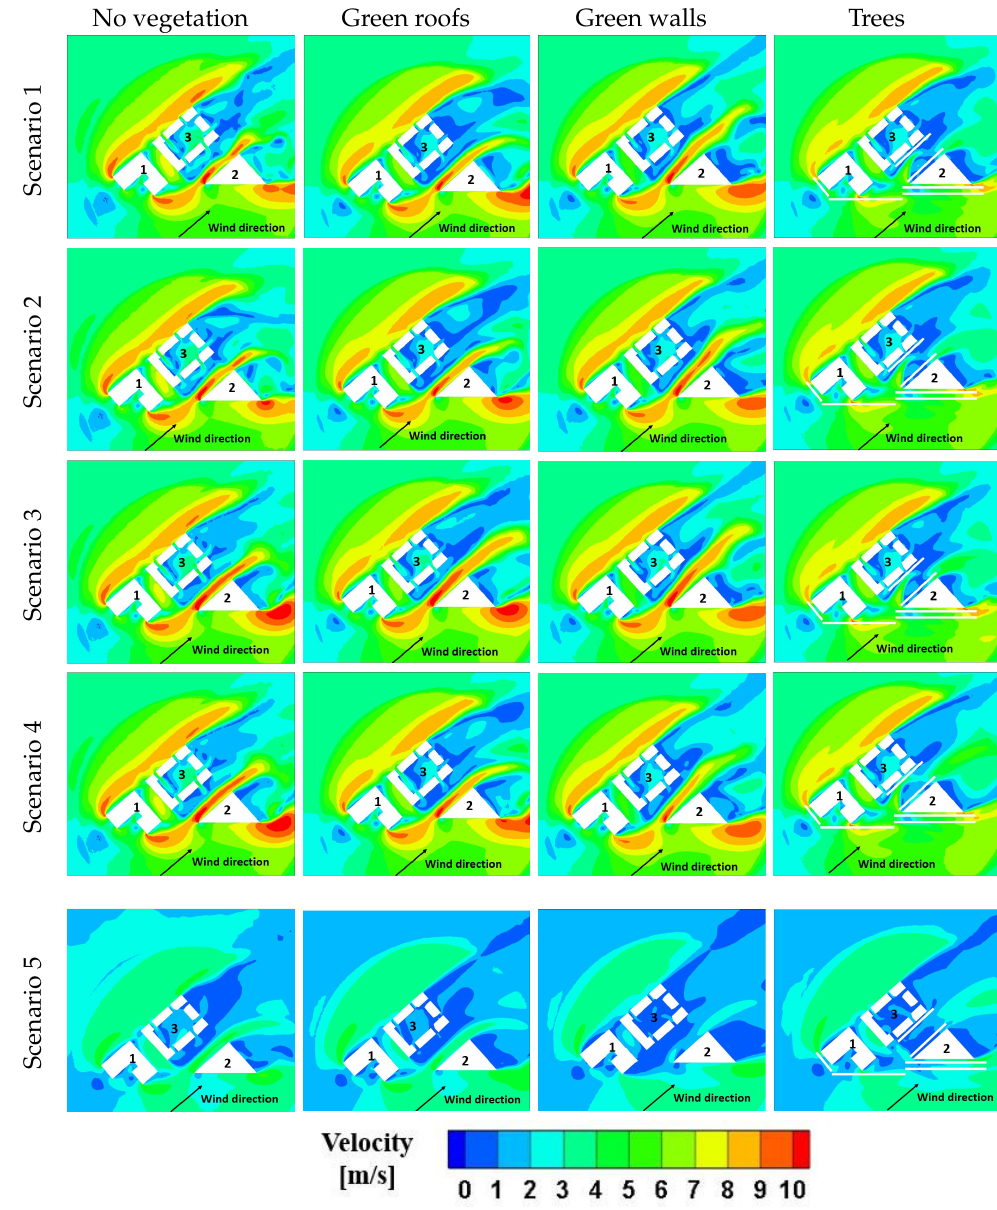
Figure 7. Contours of velocity at the pedestrian level. By looking at the contours and the area-weighted average of velocity, it is clear that the trees are the best option in reducing velocity among all the tested test cases. However, trees are not as effective as green walls and green roofs in reducing pollution dispersion. In comparison to green walls and trees, the outcomes of this study demonstrate that planting green roofs on tall buildings may not be a cost-effective solution for reducing the UHI